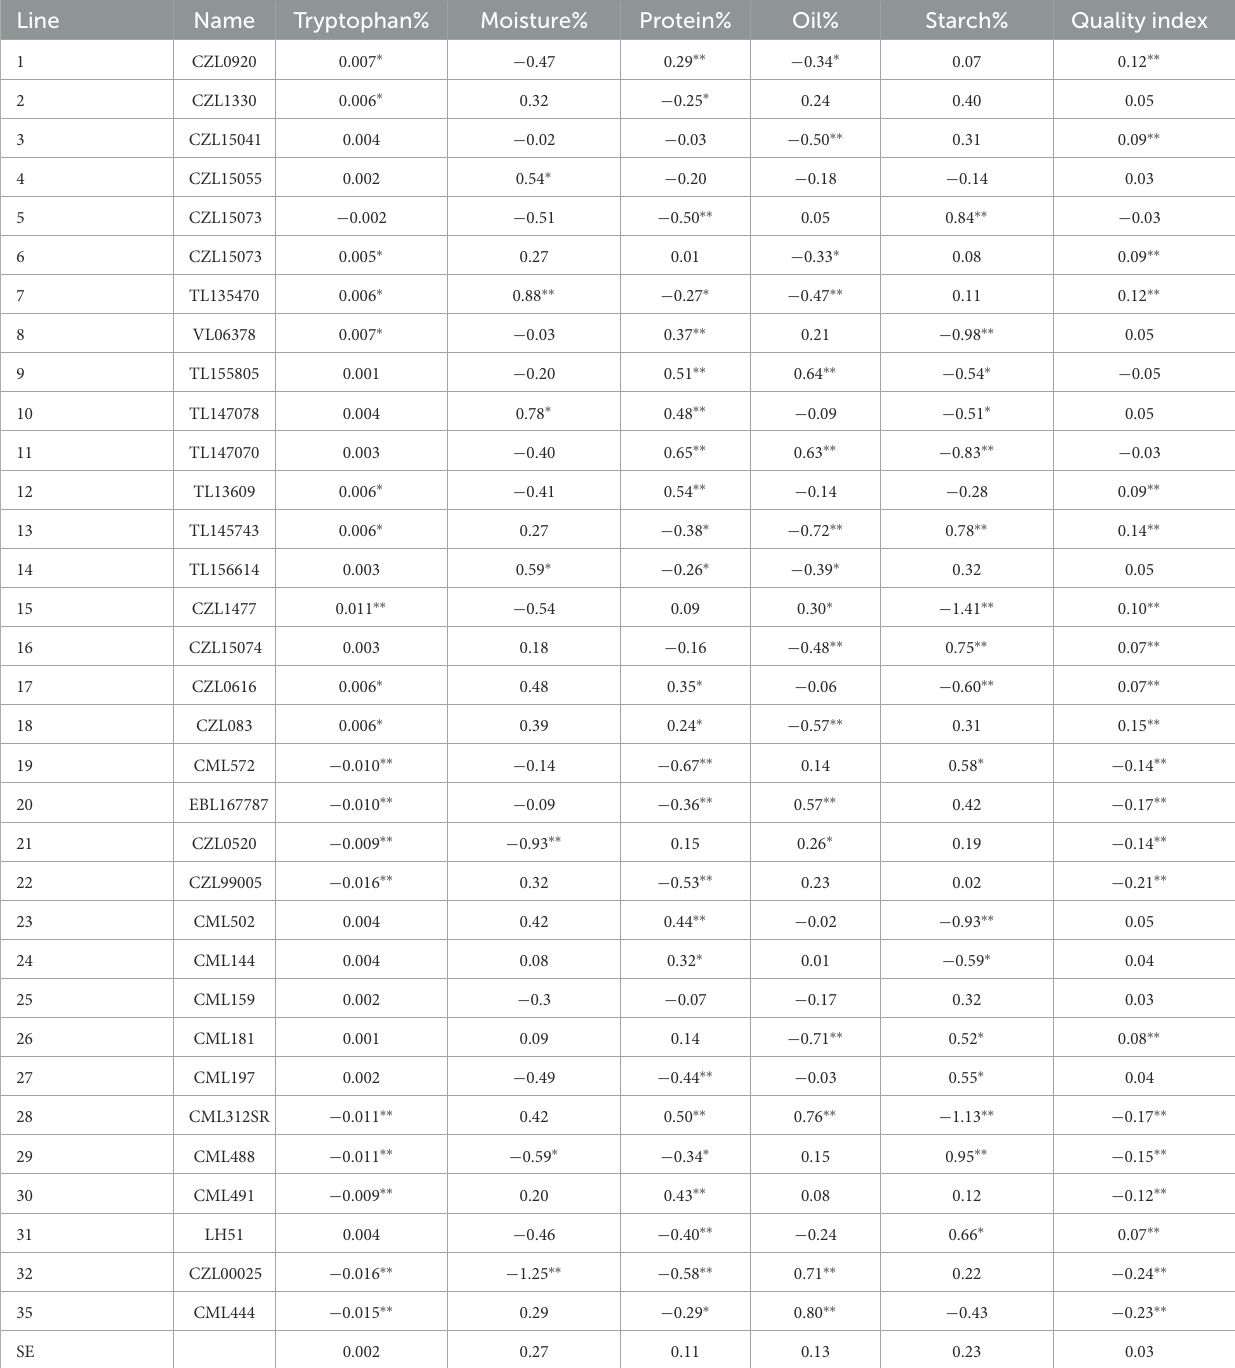
TABLE 7 General combining ability effects of 33 lines for quality traits across six sites during the 2017/2018 and 2018/2019 cropping seasons in South Africa and